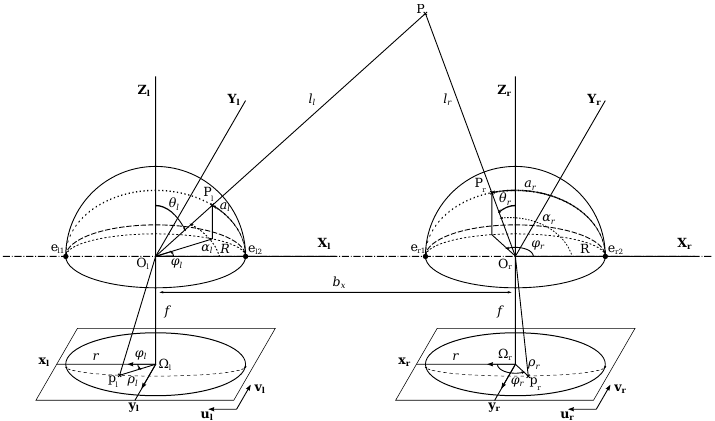
Figure 6. A stereoscopic sensor. Point P projects on the left and right spheres respectively in P l et P r , and is seen as p l and p r in the